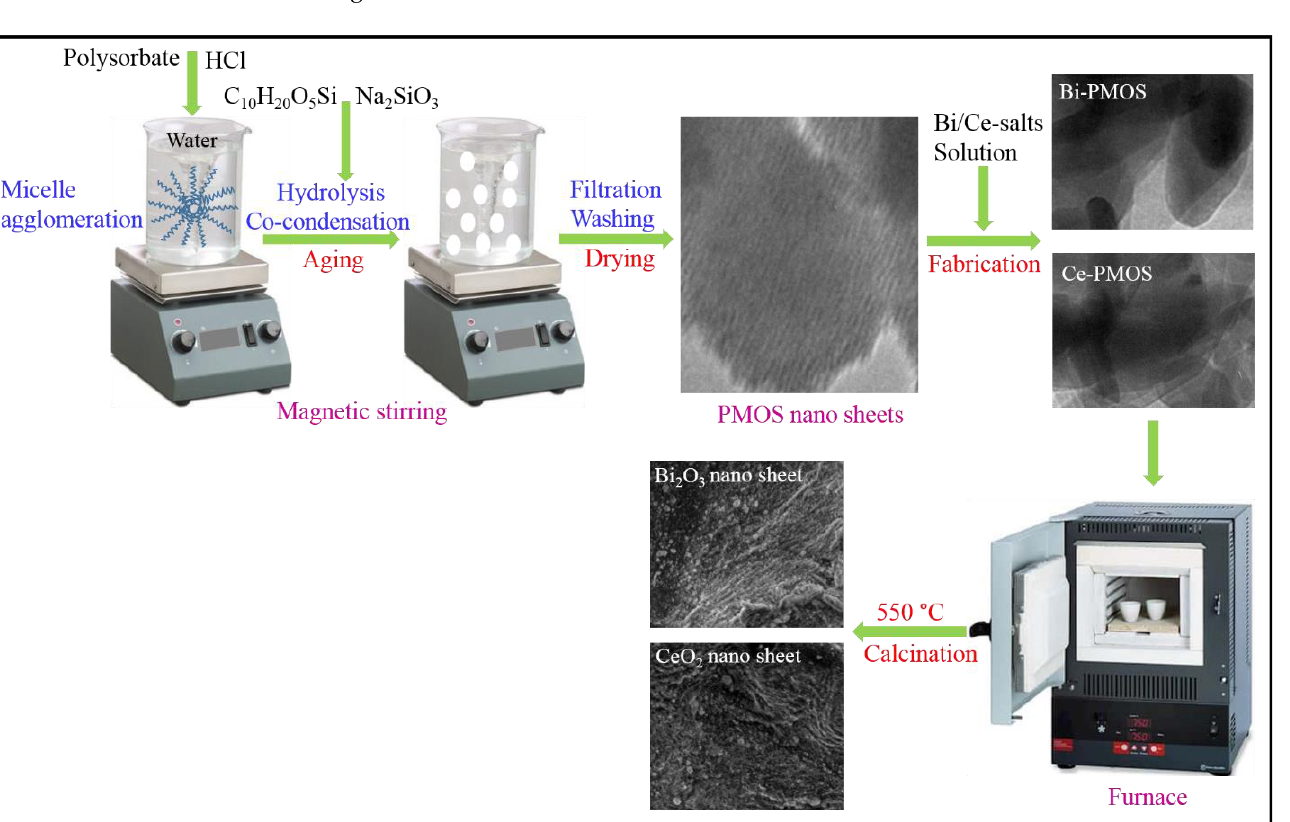
Figure 7. Synthetic scheme of Bi 2 O 3 and CeO 2 nanosheets.